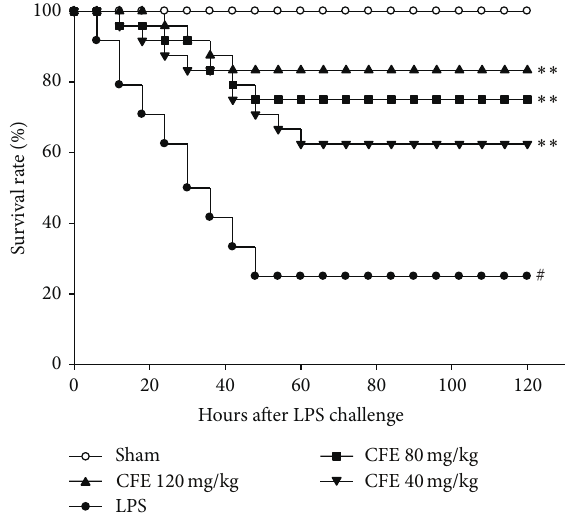
Figure 1: The effect of CFE on survival rates. Data was represented asthemean ± SEM( 𝑛 = 24 ). # 𝑃 < 0.01 comparedtotheshamgroup; ∗ 𝑃 < 0.05 and ∗∗ 𝑃 < 0.01 compared to the LPS